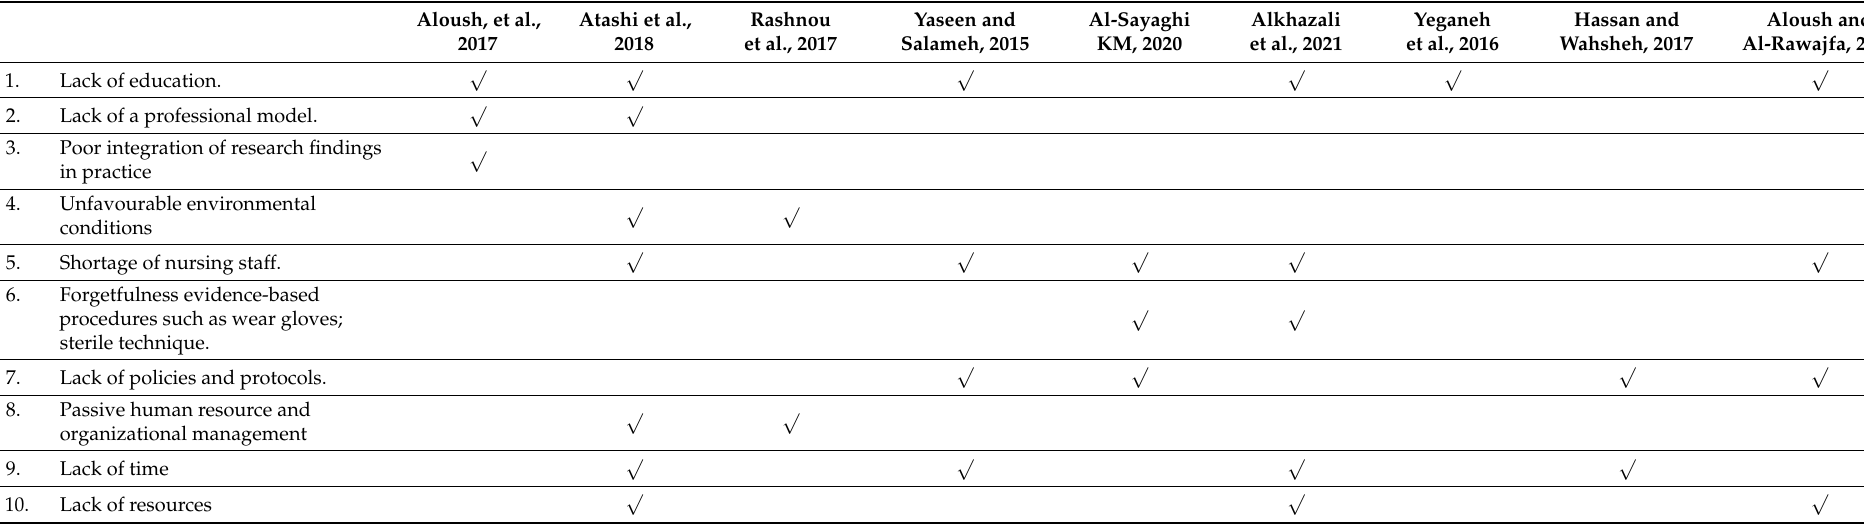
Table 4. Barriers to adherence to VAP